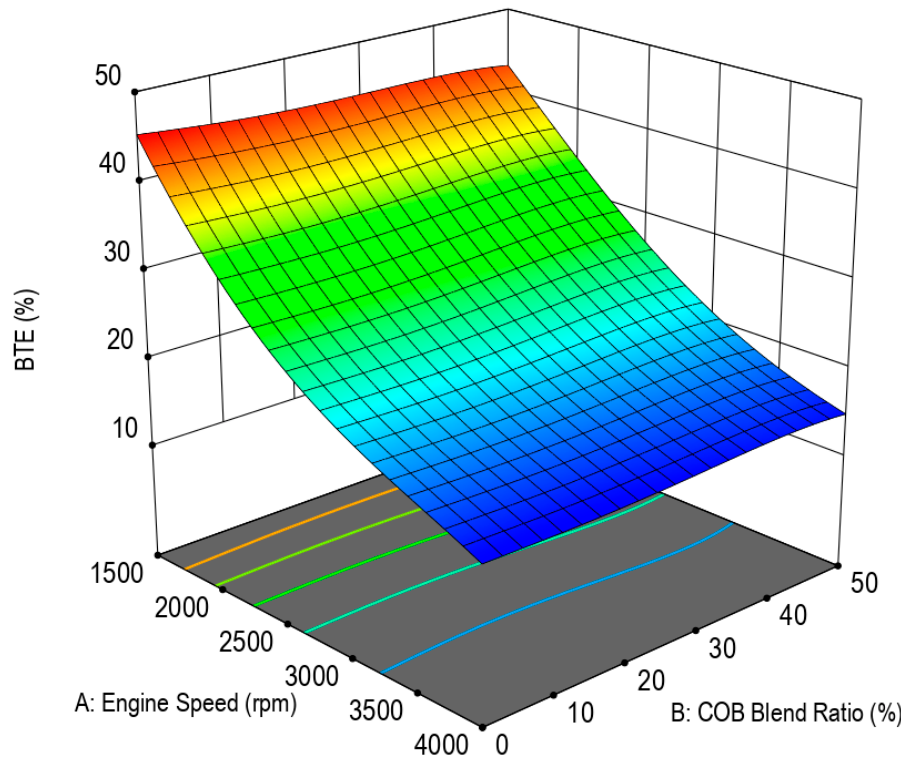
Figure 6. Brake thermal efficiency (BTE) at various engine speeds for all test fuels. Processes 2020 , 8 , x FOR PEER REVIEW